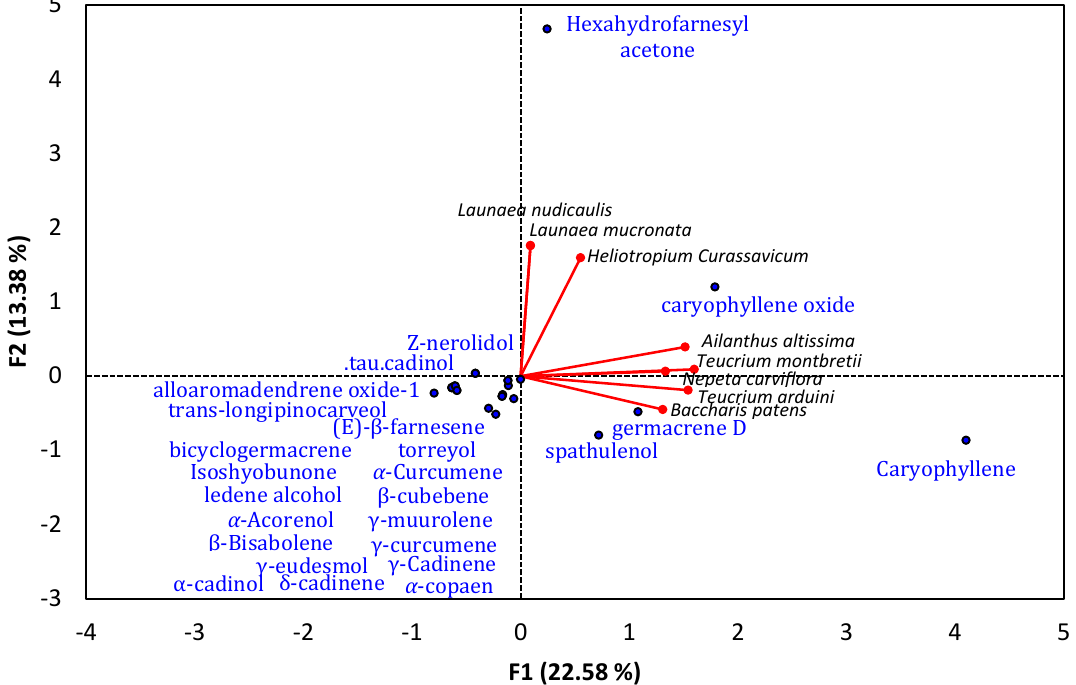
Figure 2. Principal component analysis of reported plants with essential oils containing sesquiterpenes as major compounds and showing allelopathic activity.